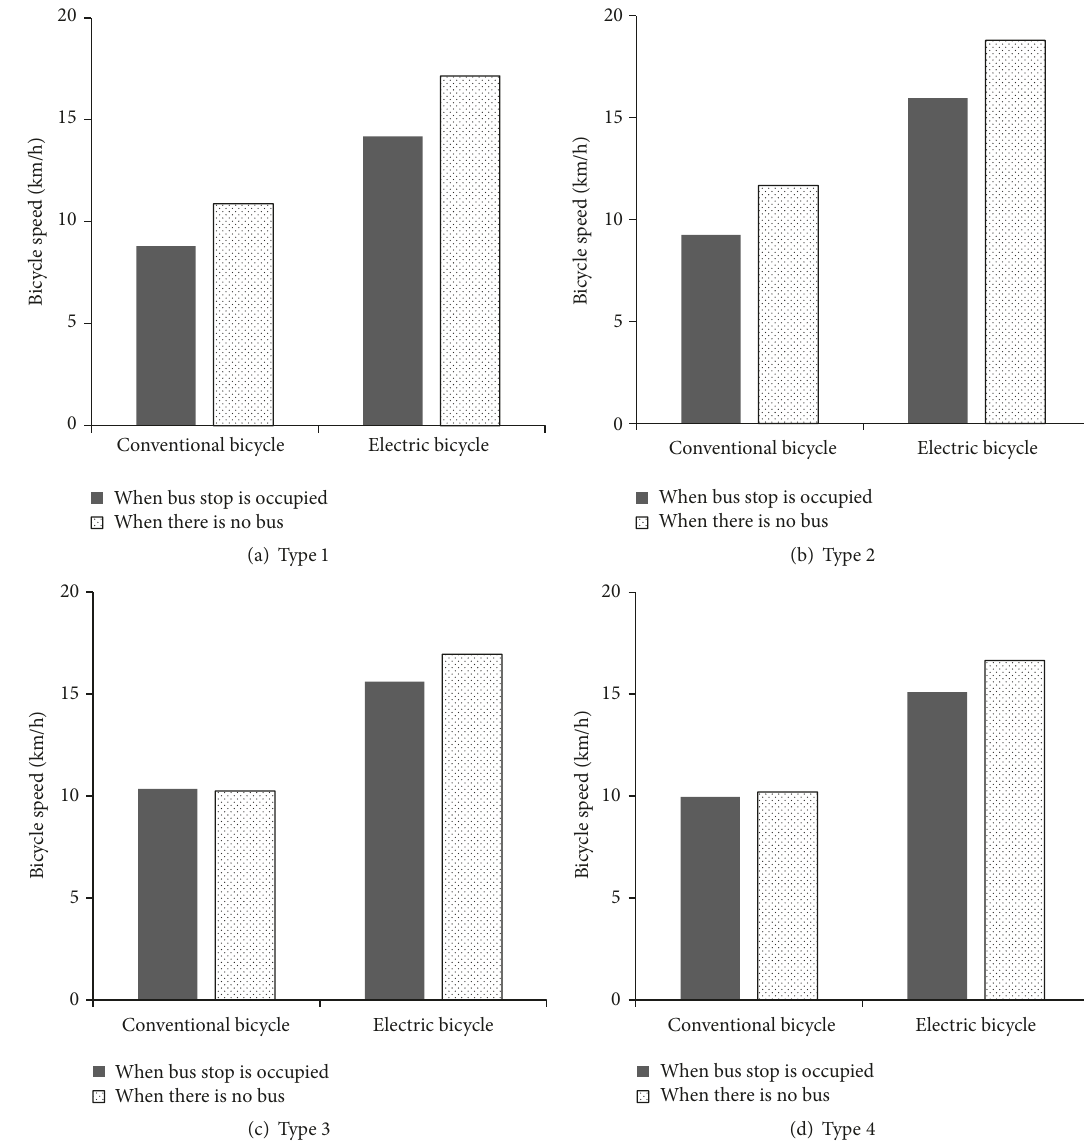
Figure 4: Bicycle speeds at different types of bus stops